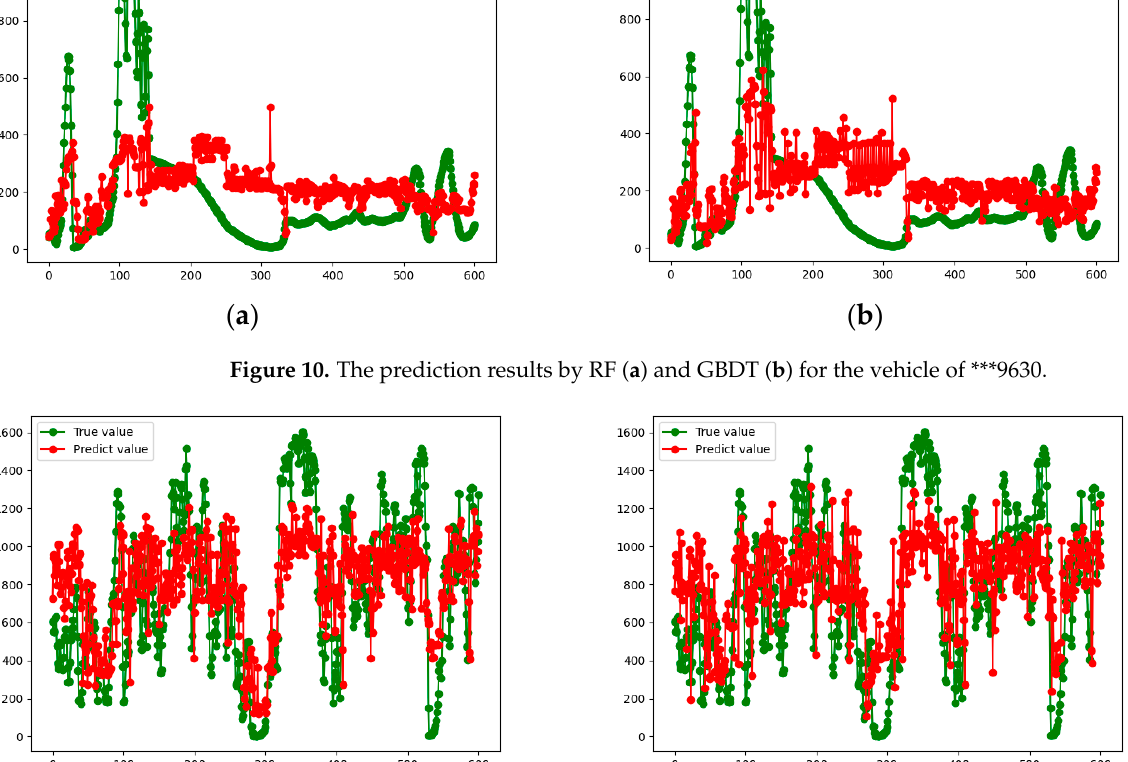
Figure 9. The prediction results by RF ( a ) and GBDT ( b ) for the vehicle of ***R580.